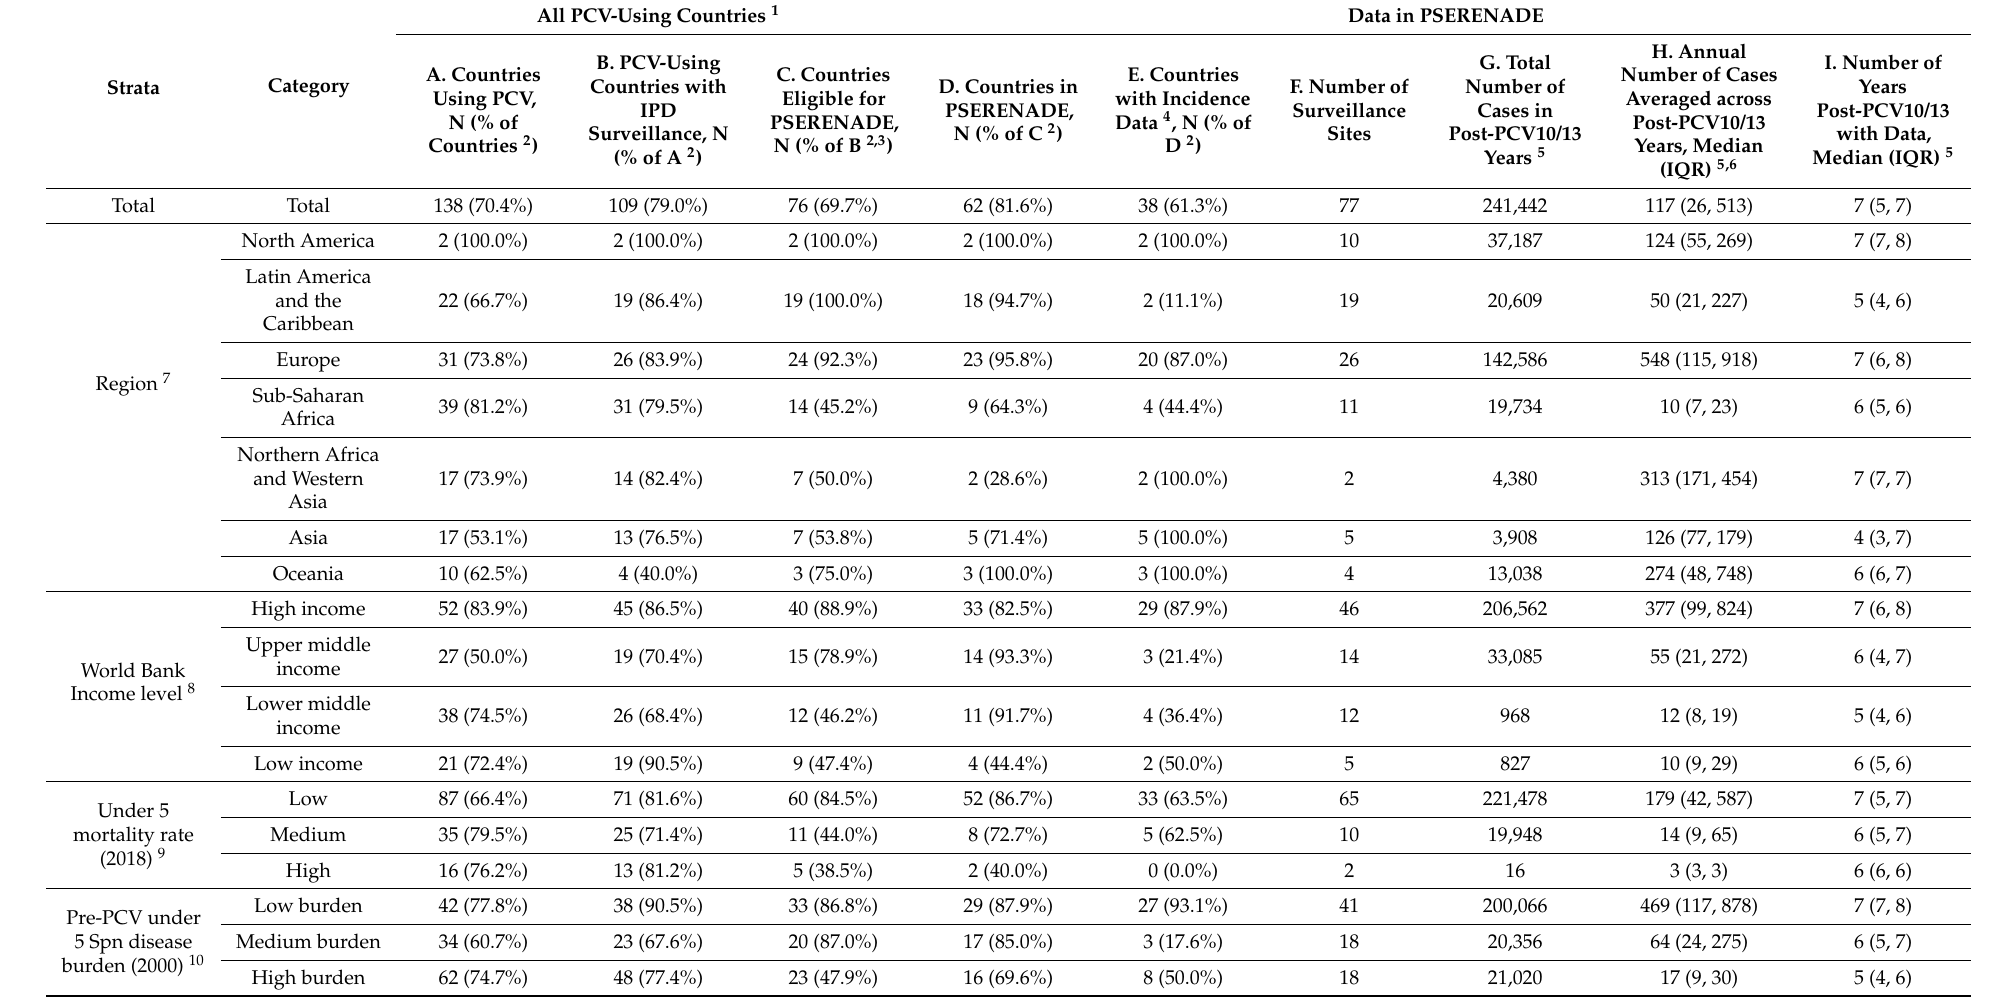
Table 3. Availability of invasive pneumococcal disease (IPD) surveillance data globally in PCV10/13-using